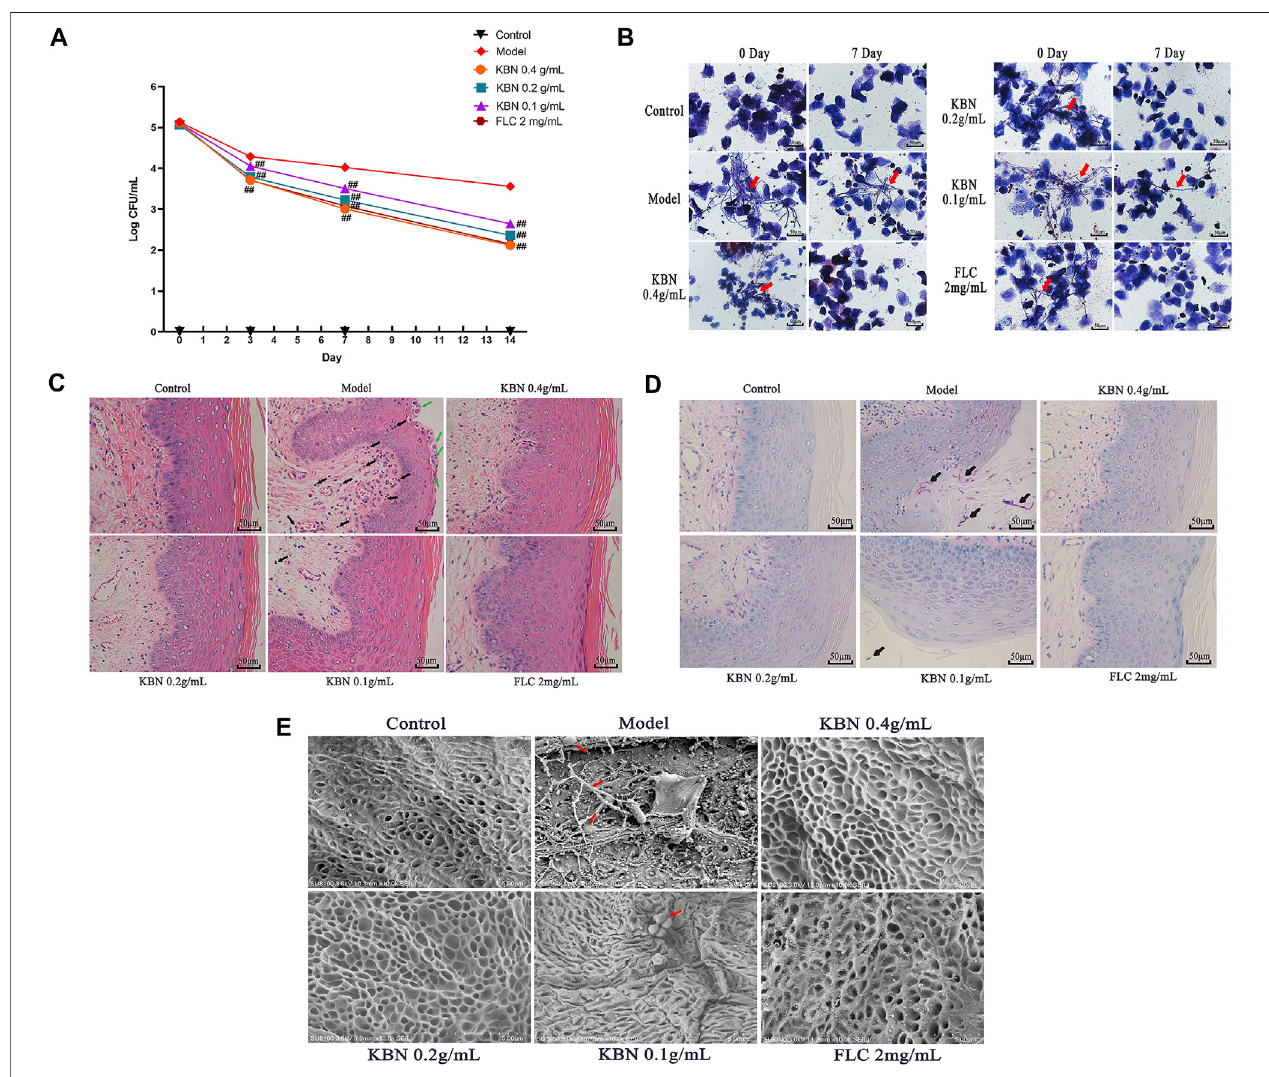
FIGURE3| Thevaginalfungalburdenandtheintensityofvaginaltissuein fl ammationinmiceinfectedwithFLC-resistant C.albicans 901afterthetreatmentofKBN. (A) Vaginalfungalburdenanalysesbycolonycountingininfectedmice.Eachvalueispresentedasthemean ± SD, N (cid:1) 10. ## p < 0.01ascomparedtothevaluesfromthe model group. (B) The formation of hyphae in vaginal excretion after KBN treatment was indicated by Gram staining (400 × ). The red arrows represent visible hyphae in vaginal excretions. (C) Histopathological analysis of vaginal tissue in infected mice by H&E stain (400 × ). The green arrow shows microabscesses and the black arrow shows neutrophils, indicating the presence of in fl ammation. (D) Histopathological analysis of vaginal tissue in infected animals by PAS (400 × ). The black arrow shows C. albicans . (E) Morphology of the vaginal epithelium by SEM after infection and KBN treatment (10 K × ). The red arrows represent C. albicans